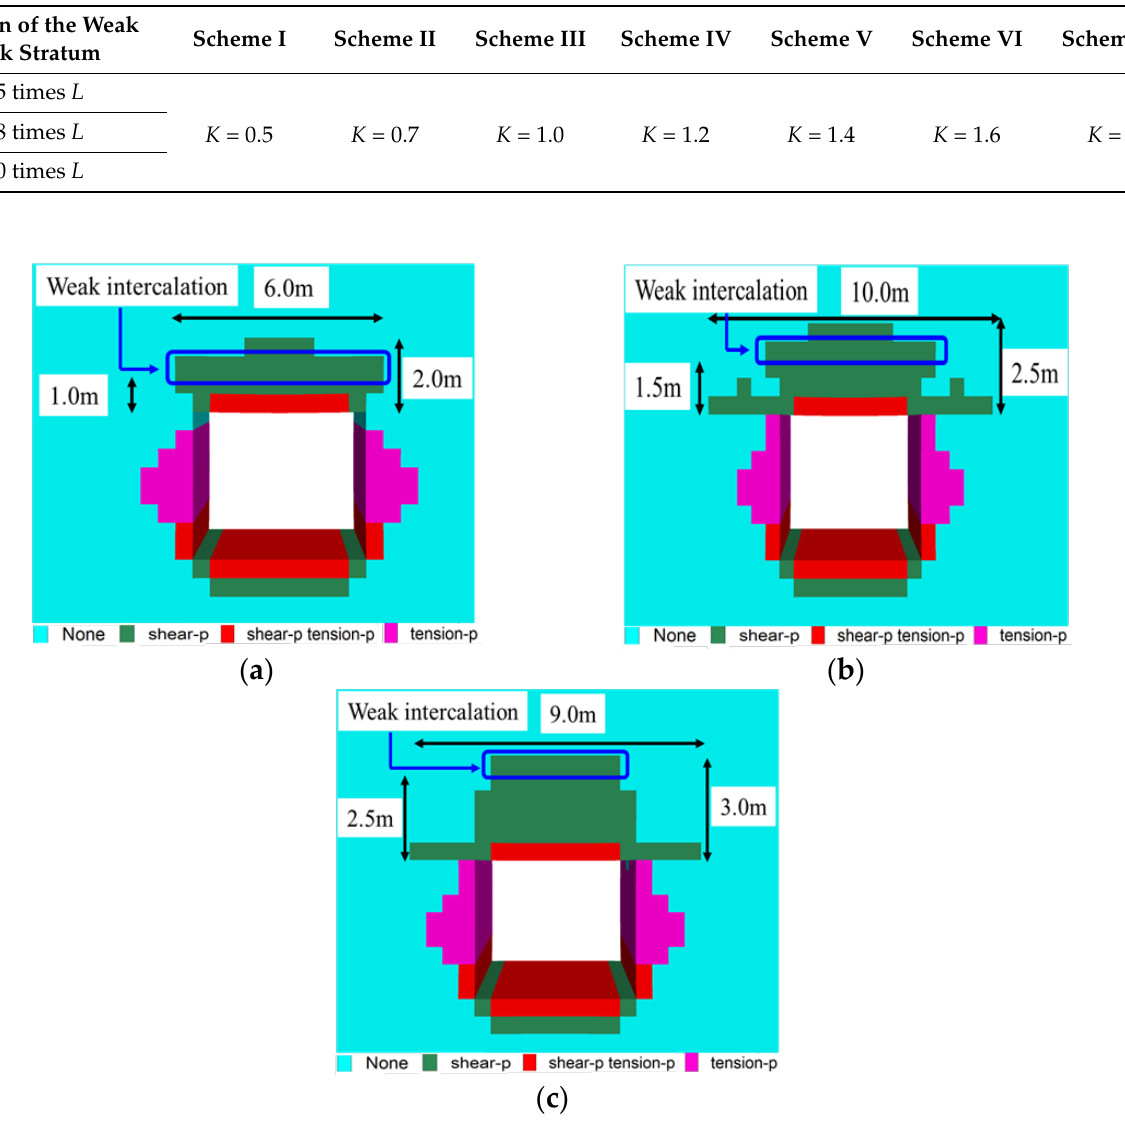
Figure 9. Simulation Results of Scheme III. ( a ) Scheme III — 0.5 times L . ( b ) Scheme III — 0.8 times L . ( c ) Scheme III — 1.0 times L .